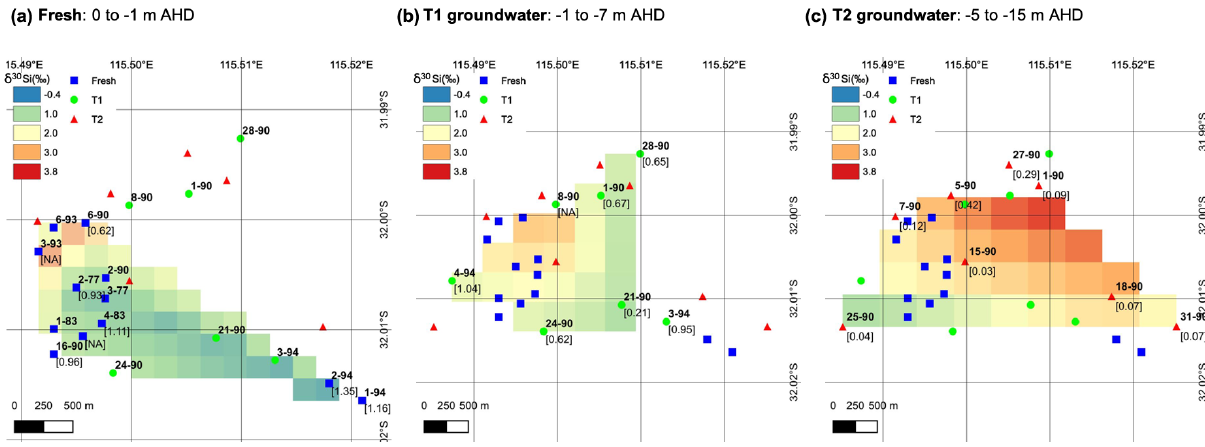
Figure 6. Interpolated spatial plots of δ 30 Si values for groundwater at RI for the (a) fresh, (b) T1 and (c) T2 groundwater. The data were created using a TIN interpolation function (cubic interpolation method) with a pixel size of ca. 0.002 (a) to 0.003 ◦ (b,c) , depending on the sample density per unit area. Sample IDs are shown in bold text next to markers, and values in square brackets show 3 H values from Bryan et al.